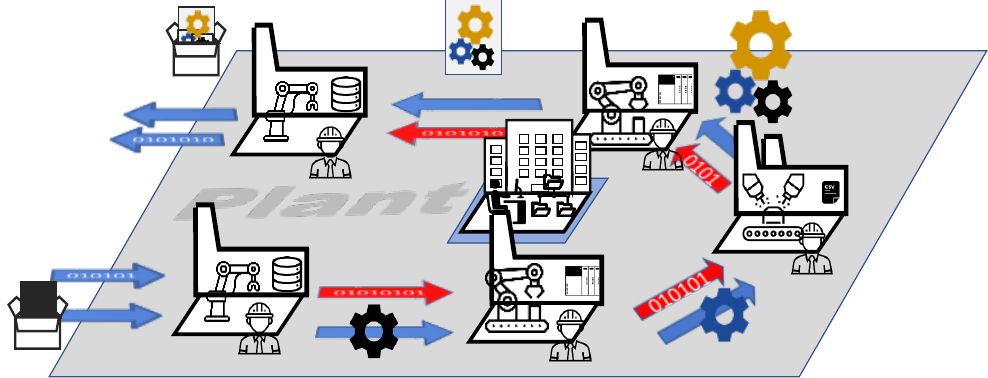
Figure 2. Example for the divisions in the production scenario with the material flow. Additionally, showing data sources from different layers of the automation pyramid and their